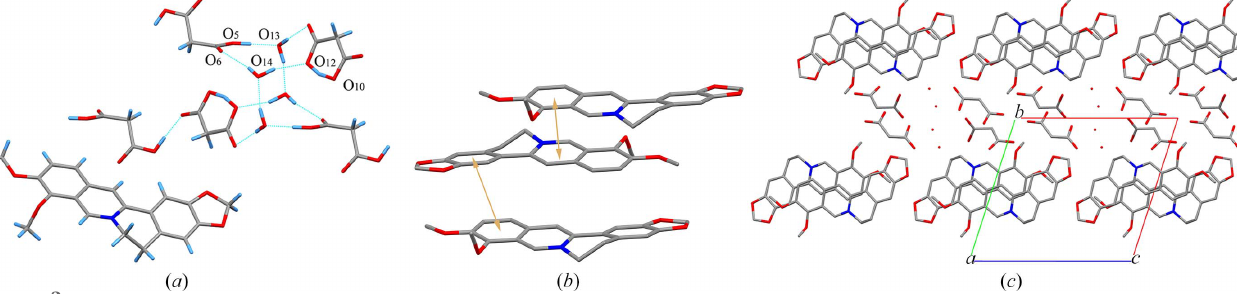
Figure 3 ( a ) Hydrogen bonds between molecules in 1BER-2MA-2W. ( b ) (cid:9) – (cid:9) interactions between molecules in 1BER-2MA-2W (hydrogen atoms have been omitted). ( c ) Three-dimensional structure of 1BER-2MA-2W (hydrogen atoms have been